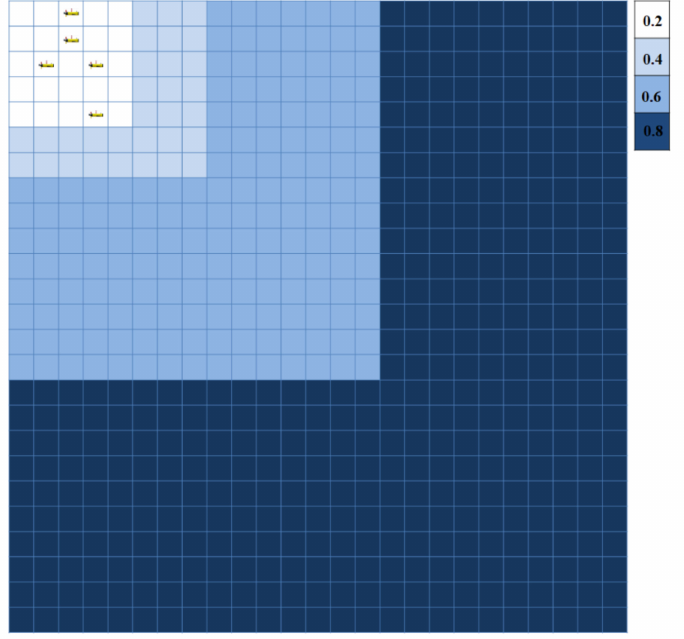
Figure 4. Changes in the depth of the search